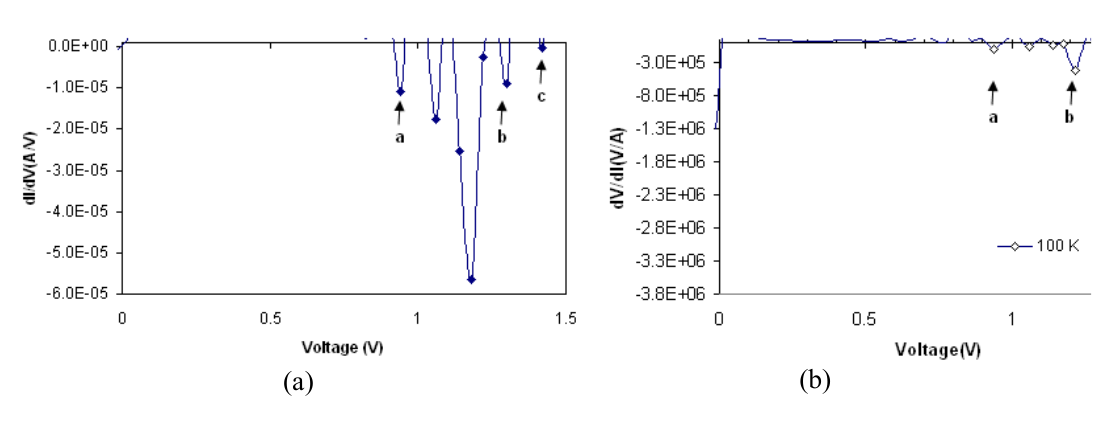
Figure 6. Differential conductance curve (dI/dV) as a function of voltage at 100 K (left figure). Differential resistance curve as a function of voltage at 100 K (right figure). Negative differential resistance can be seen at points a, b and c.